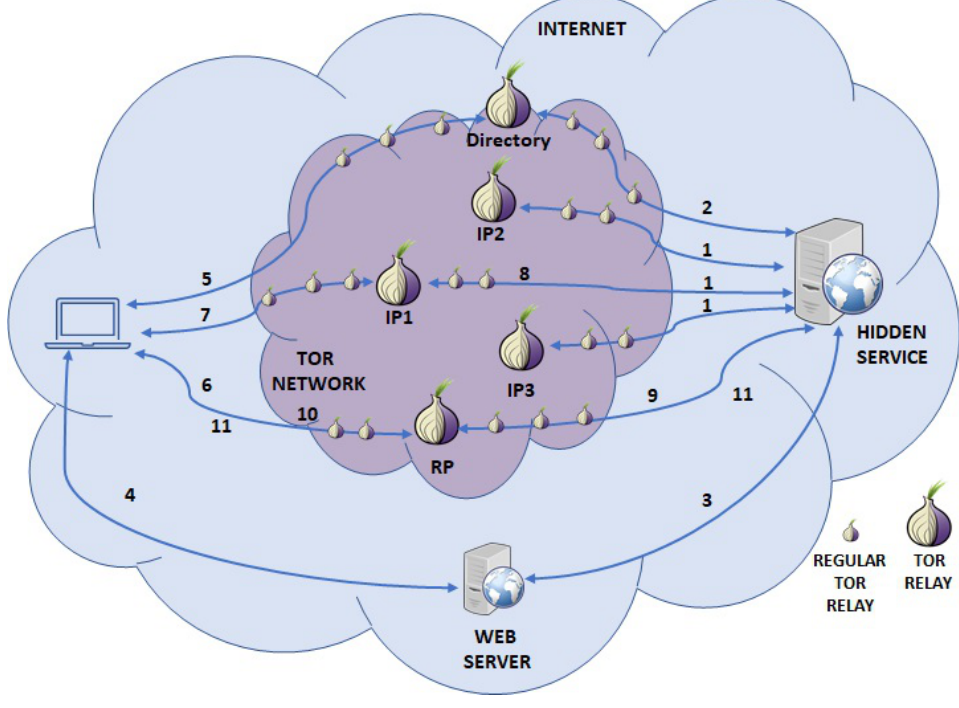
Figure 2. Tor hidden/onion service protocol. Source: